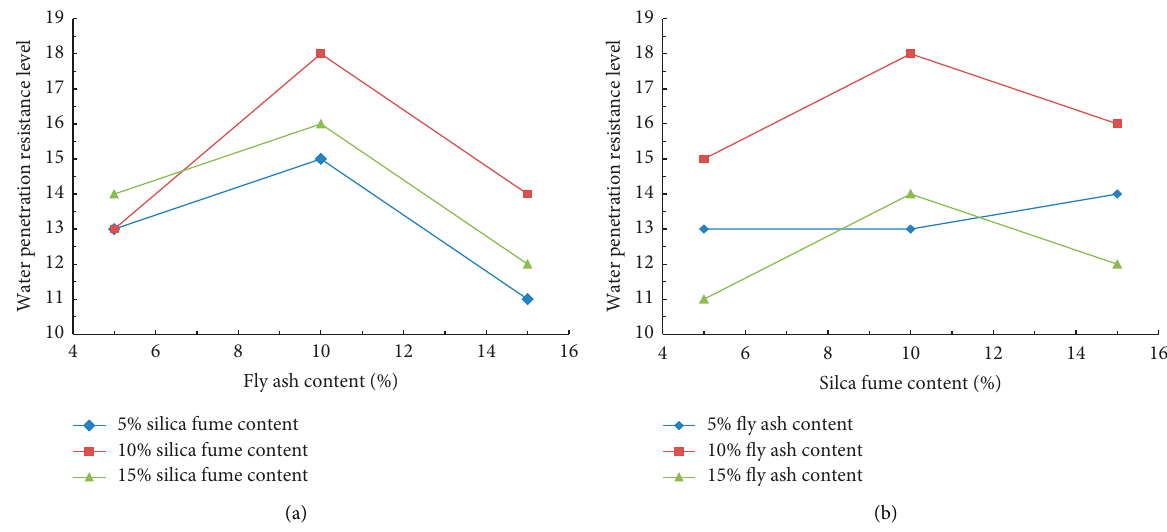
Figure 14: Influence of fly ash and silica fume on water penetration resistance of MPPF coral concrete. (a) Influence of fly ash content on water penetration resistance of concrete. (b) Influence of silica fume content on water penetration resistance of